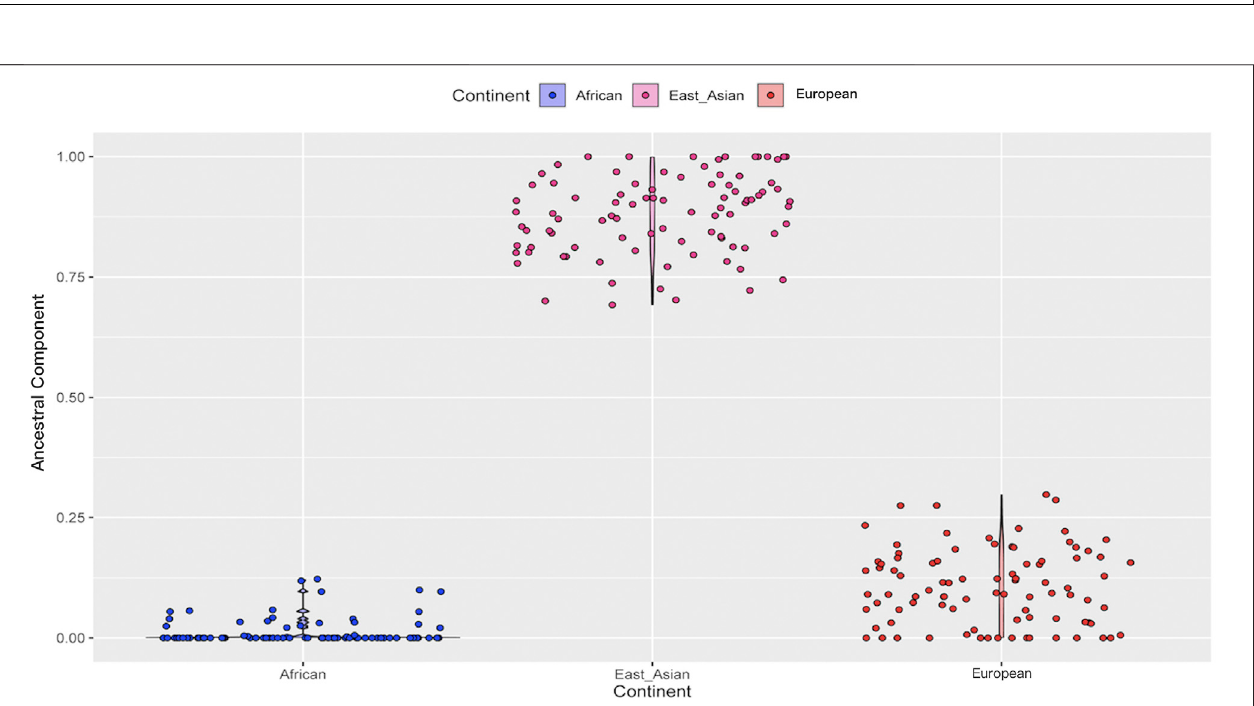
FIGURE 9 | The prediction of ancestral components for the Northwest Hui group on the basis of 55 AISNPs genotypes. AISNPs, ancestry-informative single- nucleotide polymorphisms.